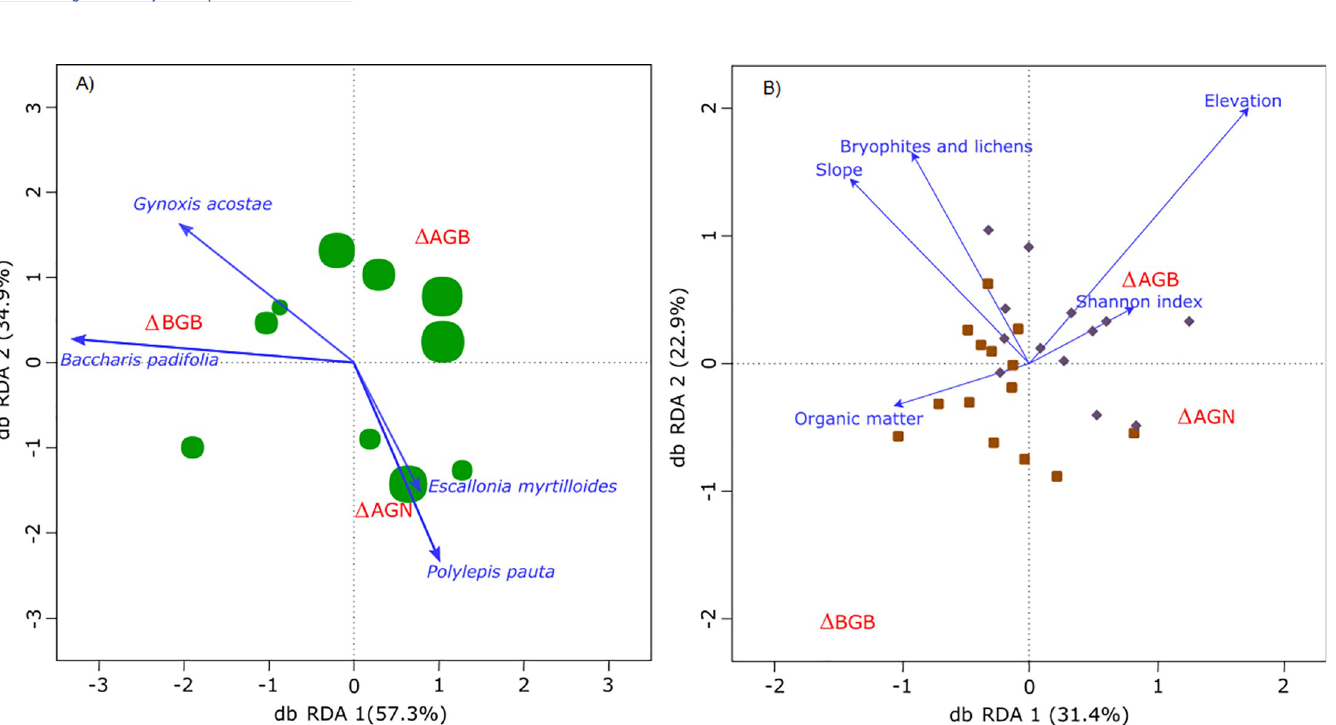
Fig 7. Biplots of distance-based redundancy analyses of the environmental and carbon stock differences for A) Andean forest and B) pa´ramo. Response variables (carbon stock differences) and sites are presented in red and blue text respectively. Andean forest plots, green circles, below 3,900 m.a.s.l.; the size of the circle is relative to the plot’s mean trunk diameter in the first census. Pa´ramo plots represented with a diamond are located above 4,100 m.a.s.l. and with a square between 3,900–4,100 m.a.s.l.